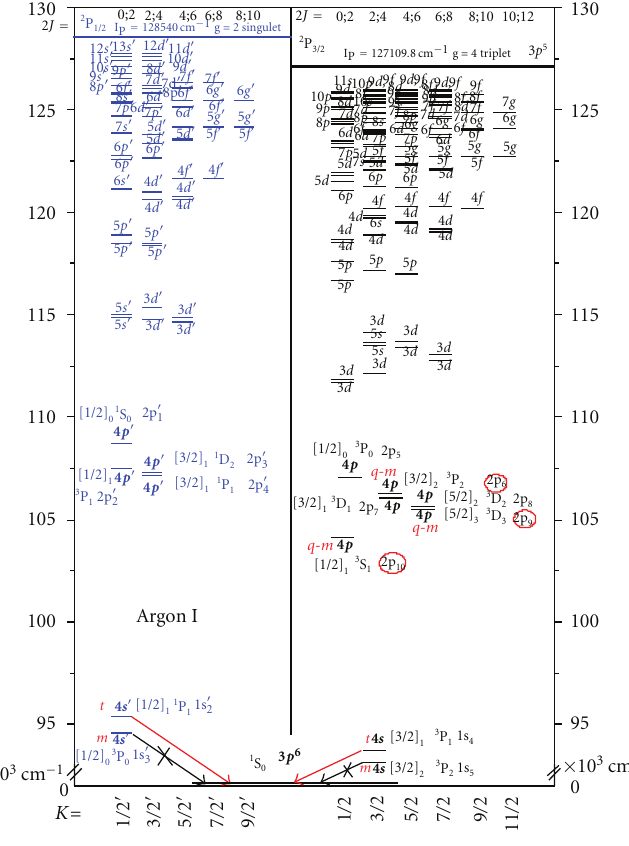
Figure 1: Grotrian diagram of Ar I. Table 1: List of the 15 lower energy levels of Ar